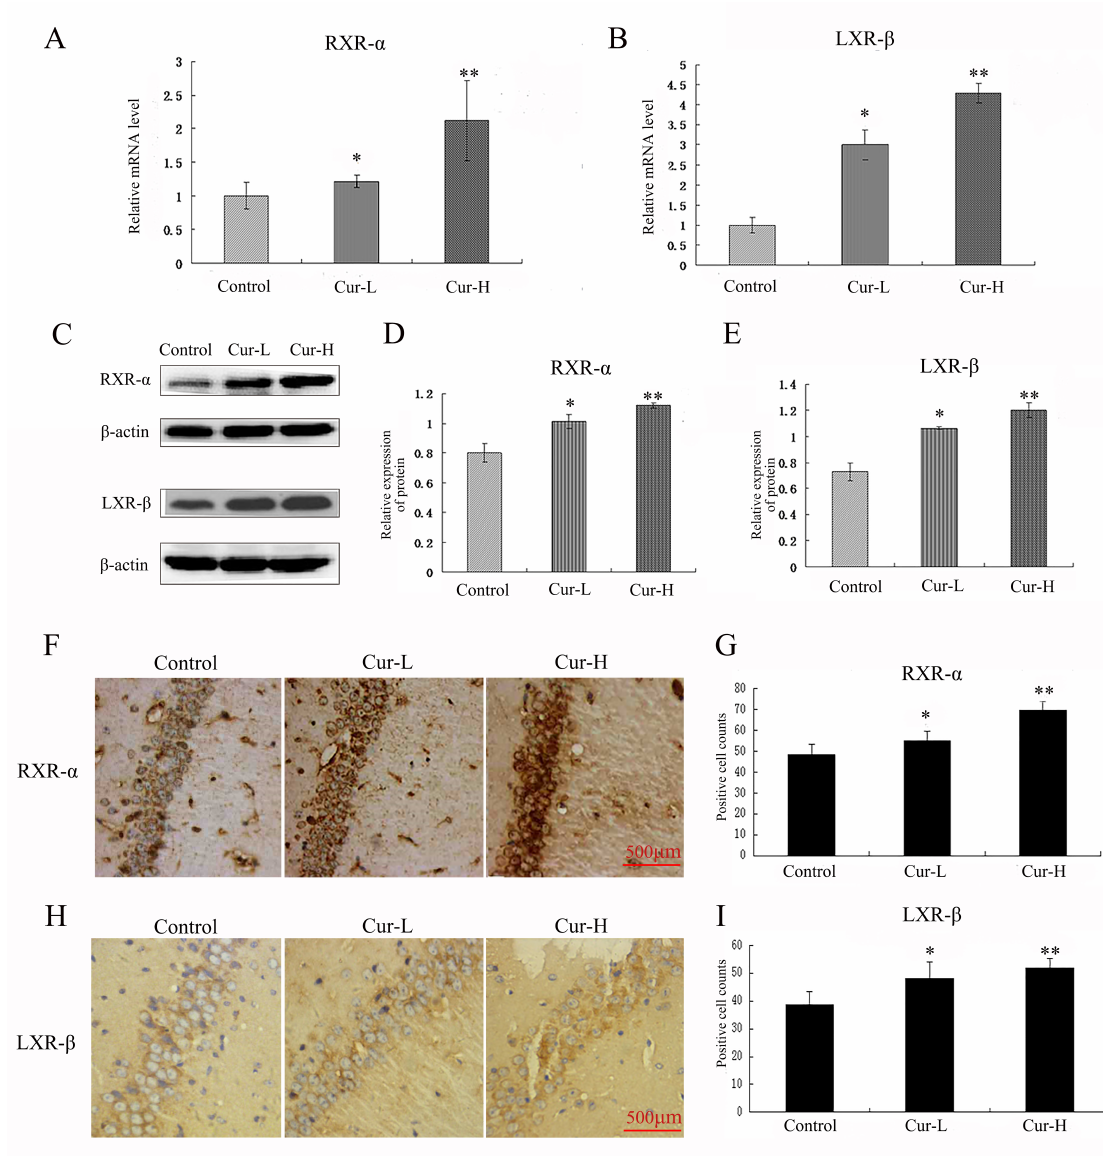
Fig. 5. Curcumin promoted the expression of RXR- α and LXR- β in the hippocampus of APP/PS1 mice. (A,B) Relative mRNA expression of RXR- α and LXR- β of every group. (C–E) Western blot analysis of RXR- α and LXR- β in each group. (F–I) Immunocytochemistry analysis of RXR- α and LXR- β in each group (Scale bar = 500 µ m). The data stands for as mean ± SEM of a typical three experimental series (* p < 0.05, versus Control; ** p < 0.01, versus